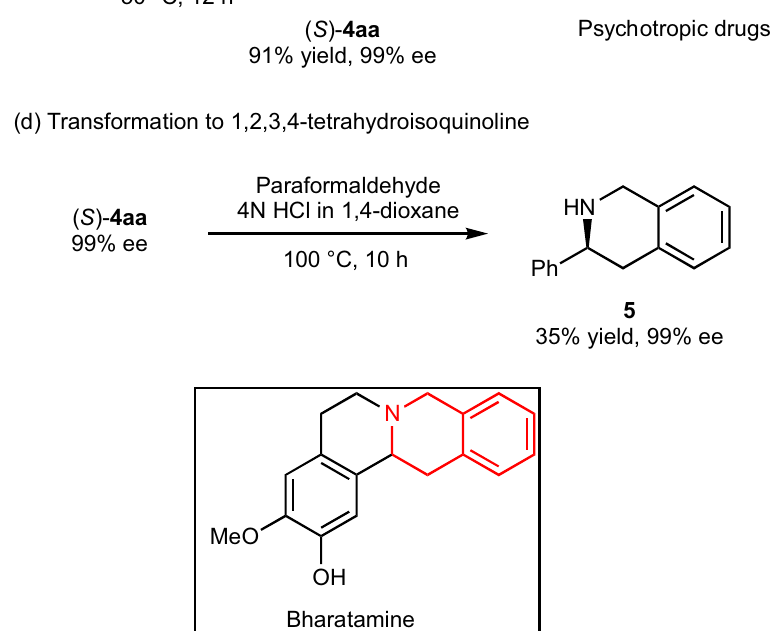
Fig. 2 Synthetic utility. a Gram-scale reaction, Reaction conditions: 1a (10 mmol), toluene (20 mL), KCH 2 SiMe 3 (0.75 mmol), KHMDS (0.75 mmol), L6 (0.83 mmol), − 78 °C, 18 h. b In-situ preparation of imine, Reaction conditions: benzaldehyde (2.0 mmol), the corresponding amine (2.04 mmol), toluene (4 mL), KCH 2 SiMe 3 (0.15 mmol), KHMDS (0.15 mmol), L6 (0.17 mmol), − 78 °C, 18 h. c Transformation to free amine and further derivatization. d Transformation to 1,2,3,4-tetrahydroisoquinoline. a After